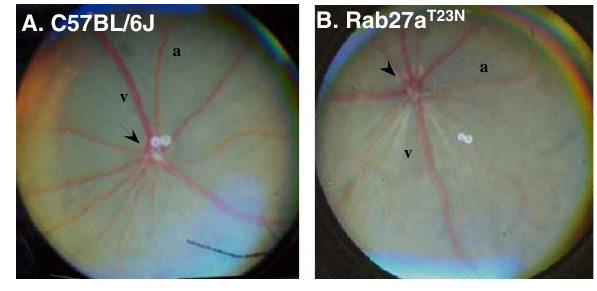
Figure 7 Photographs of the fundus of the Rab27a T23N transgenic mouse. Wild-type (C57BL/6J control littermate) ( A ) and Rab27a T23N transgenic mouse (A27aT25/2 line) ( B ) were photographed at 6 months of age as described under "Meth- ods". The venules (v) are twice the diameter of the arterioles (a). The optical nerve head is indicated by an arrow. Note that the two white dots are result of light reflection on the lens between the camera and the mouse's